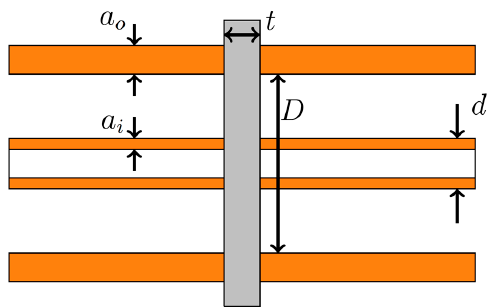
Figure 9. Longitudinal cross section of the measurement assembly.